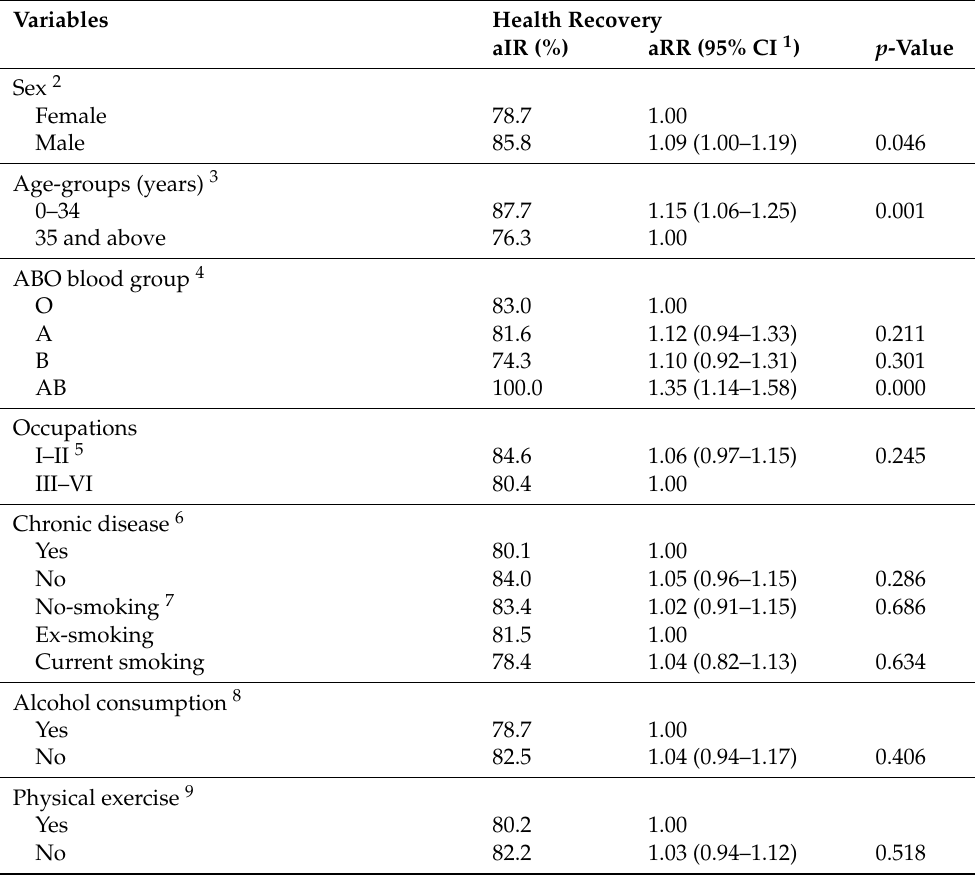
Table 7. Health recovery, risk factors, adjusted incidence ratio (aIR) and adjusted relative risk (aRR).Borriana COVID-19 cohort